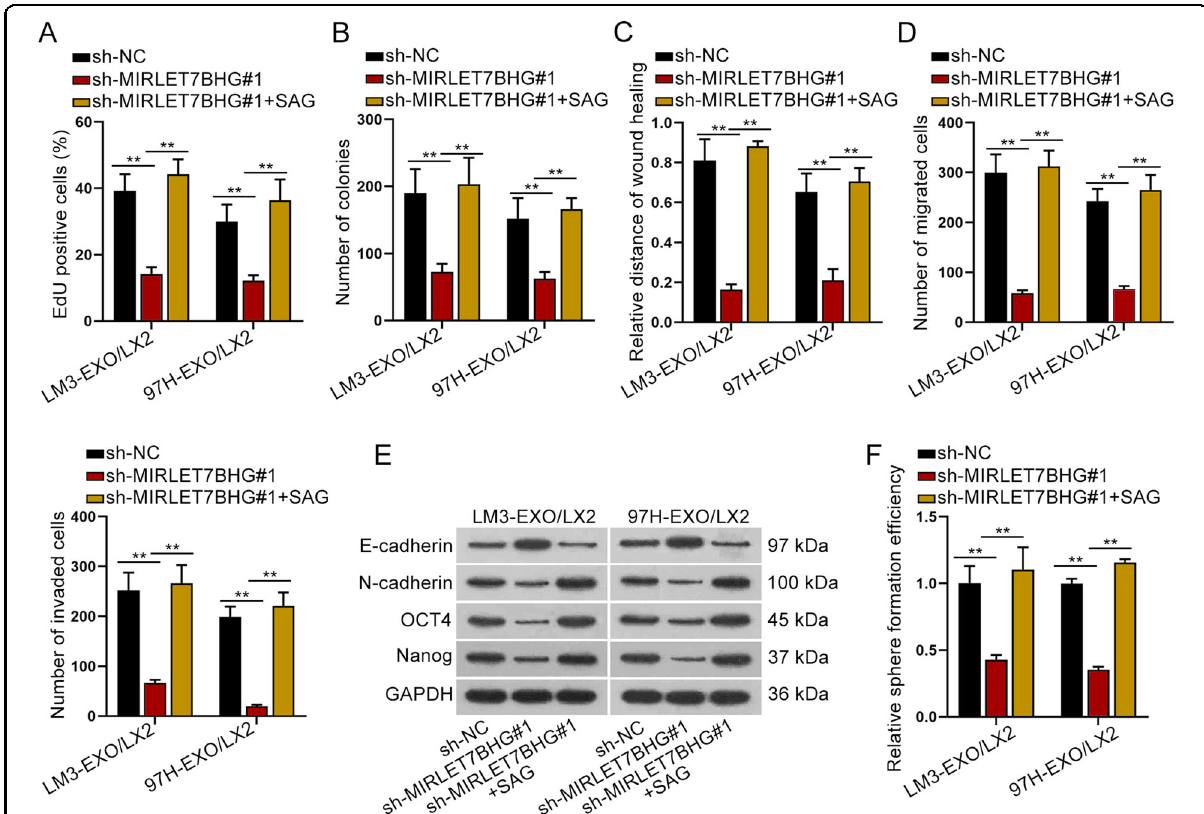
Fig. 7 SMO mediated HSC activation via Hedgehog pathway. There were three groups of activated HSCs with different treatments: sh-NC, sh- MIRLET7BHG#1, and sh-MIRLET7BHG#1 + SAG. A – B EDU and colony formation assays assessed the rescue effects of SAG on MIRLET7BHG de fi ciency- affected cell proliferation. C – D Wound-healing and transwell assays monitored cell migration and invasion in different groups. E – F Western blot and sphere formation assay evaluated the in fl uences of SAG on MIRLET7BHG depletion-hampered EMT and stemness in activated HSCs. ** P <